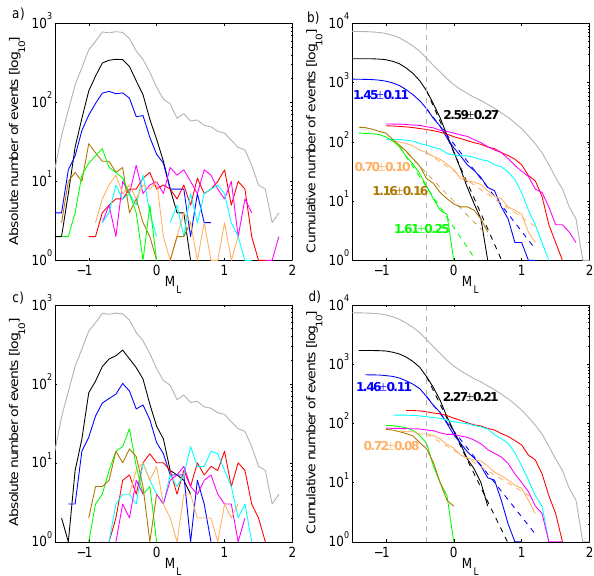
Fig. 9. Result of the double difference relocation of the events de- picted in Fig. 7 in (a) map view, (b) N–S depth section and (c) E–W depth section. The largest clusters discussed in the text are plotted in colour according to the previous figures. The remaining events of the catalogue are depicted in grey.